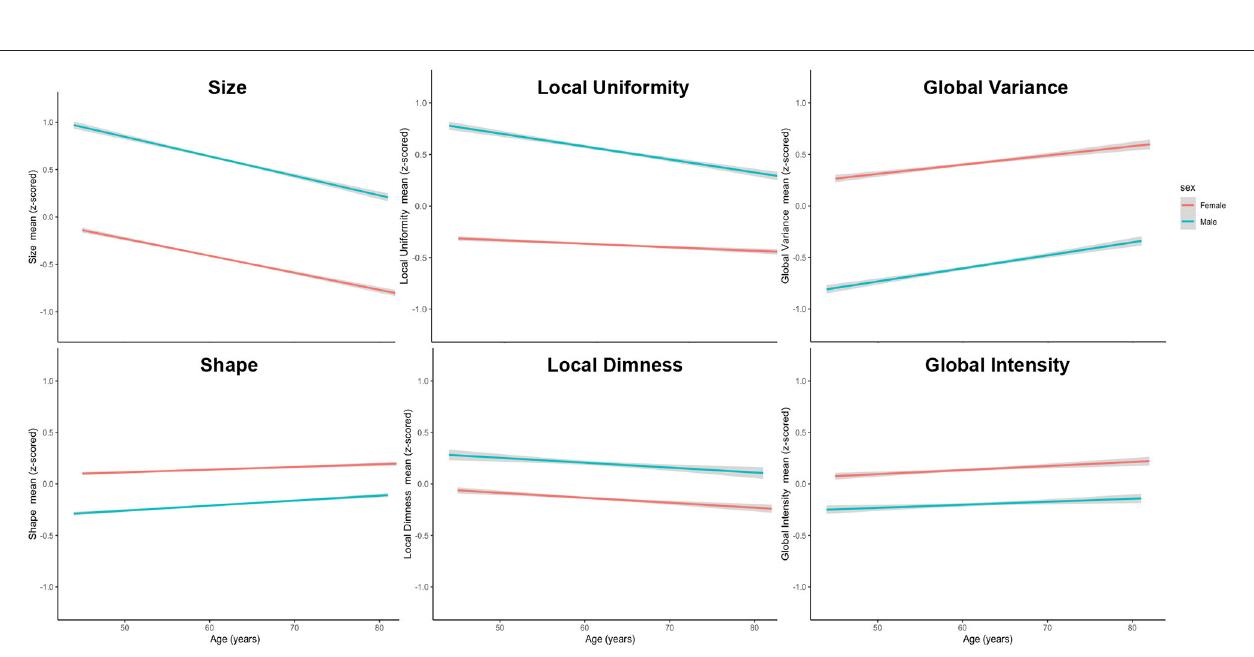
FIGURE 3 | Mean standardised radiomics value for each feature cluster stratified by sex across all ages. Men had larger (higher size values) and more elongated (higher shape values) ventricles than women. Men had dimmer less varied signal intensities at both a global (lower global intensity, lower global variance) and local (higher local uniformity, higher local dimness) level. Alteration of radiomics features with ageing were generally consistent for men and women. There was more rapid decline in local uniformity in men with minimal age-related change in this cluster for women.